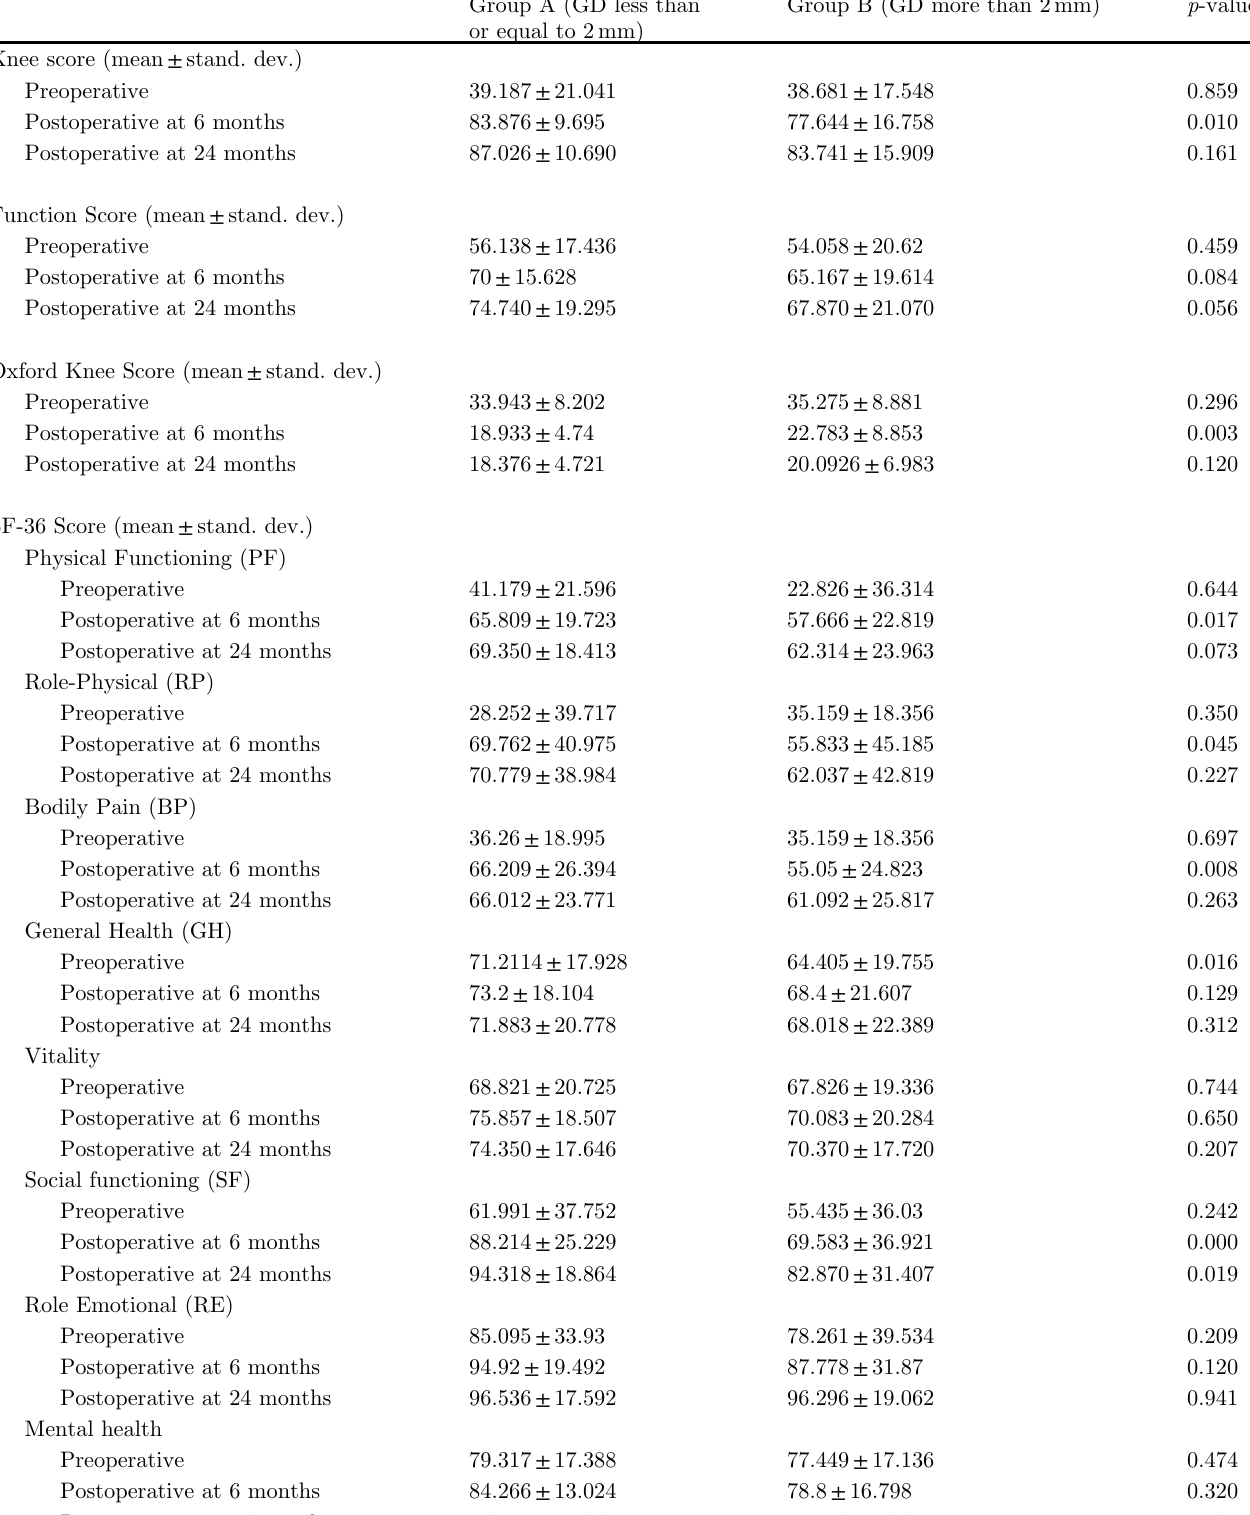
Group B (GD more than 2mm) p -value